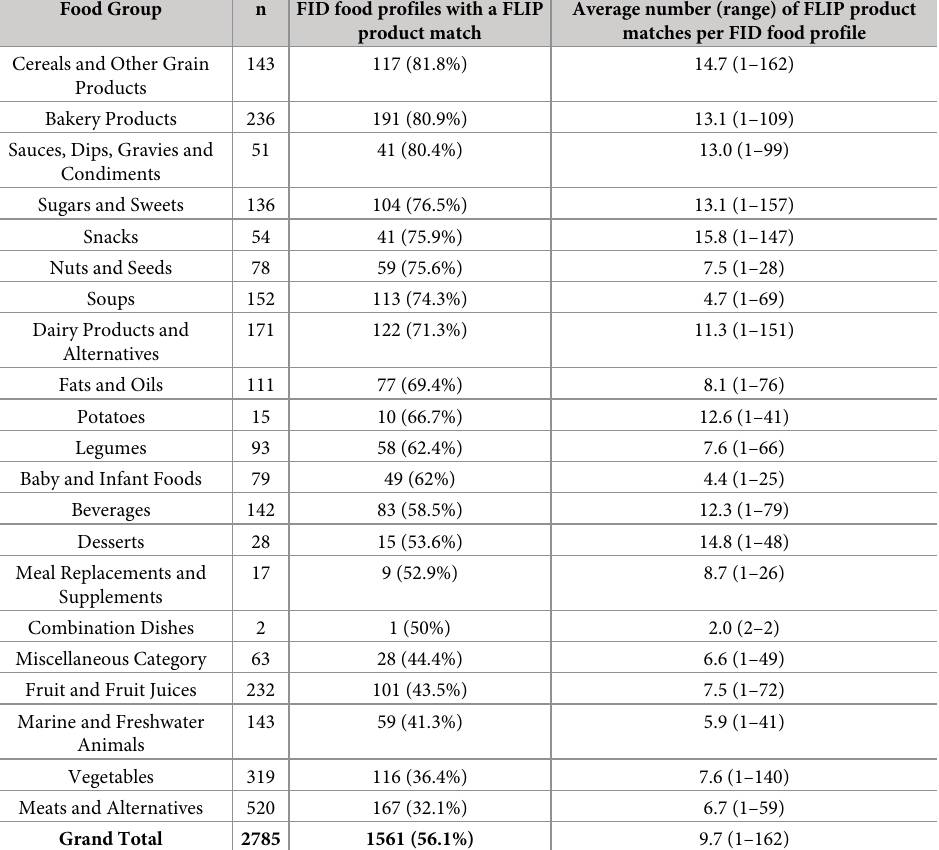
Table 2. Number and proportion (%) of FID food profiles that were matched with a FLIP product and the average number and range of FLIP matches per FID food profile, overall and by major food group (n = 2785 FID food pro- files) a .